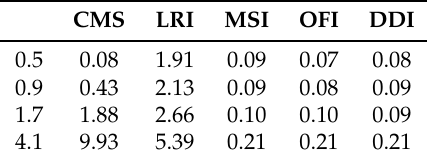
Table A3. Accel.LN in short distance.